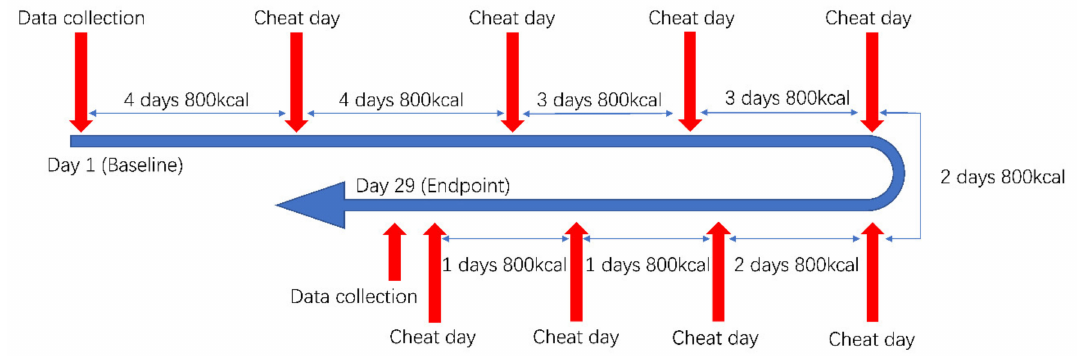
Figure 1. The progress of the intermittent energy restriction